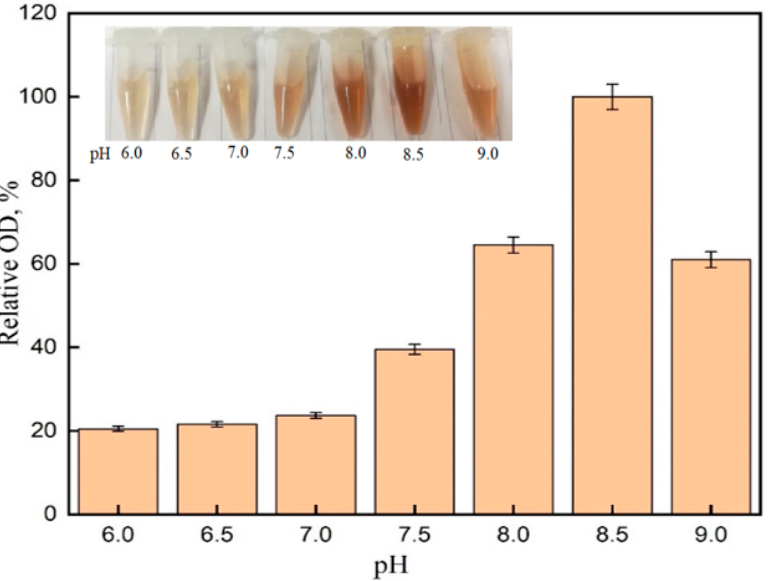
Figure 3. Effect of time on the color evolution of gelatin-silver reagent. Conditions: A 1 mL of the reaction mixture contained 250 µL maltose (0.1 mM), 250 µL of 0.2 M Tris–HNO 3 buffer PH 8.5, 500 µL gelatin-silver reagent (1:3), incubated for different times at 90 °C in a boiling water bath, cooling, recorded the absorbance at 434 nm. Each point represents the mean of three experiments ± SE.